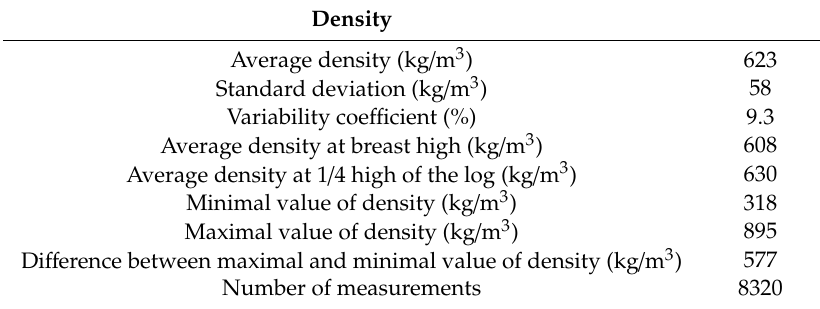
Table 5. Two-sided t -test of the di ff erence between average densities (at significance level p = 0.05) for density distribution in birch wood. Parameter Average density of all logs / Average density at breast height Average density of all logs / Average density at 1 / 4 high of the log